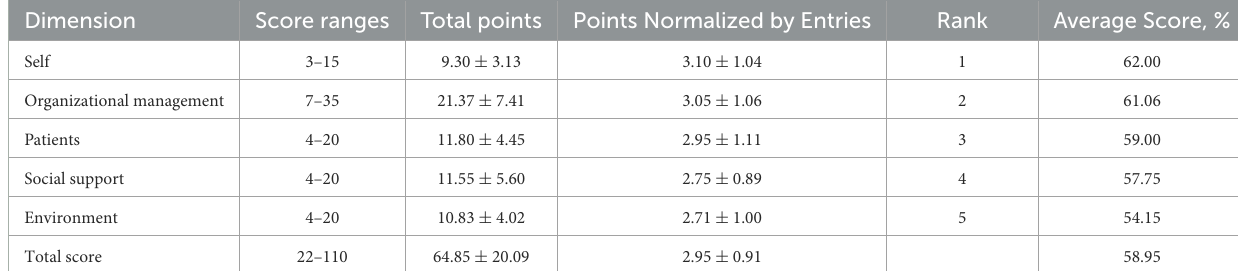
TABLE 2 Job security scores across each dimension ( n =